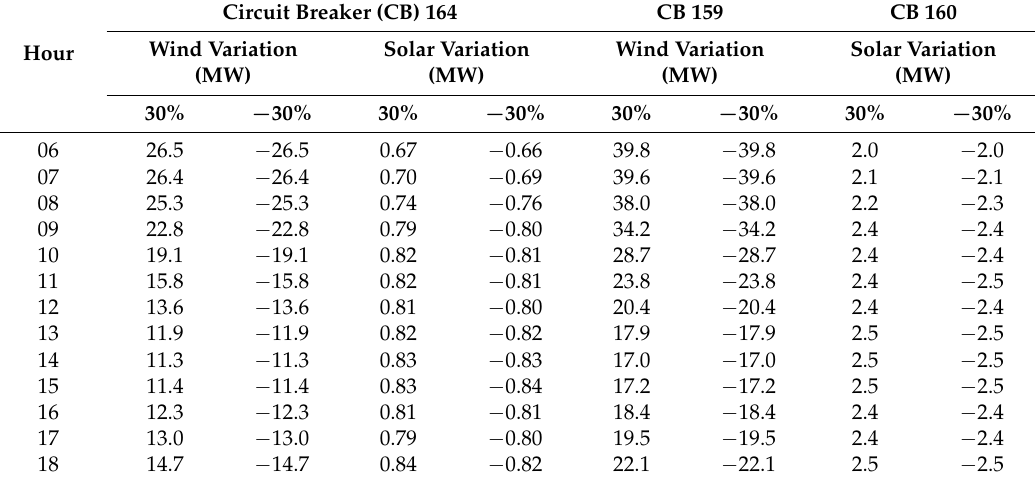
Table1. Active Power Flow Variations (MW) Through Circuit Breakers of Sobradinho 230 kV Substation.